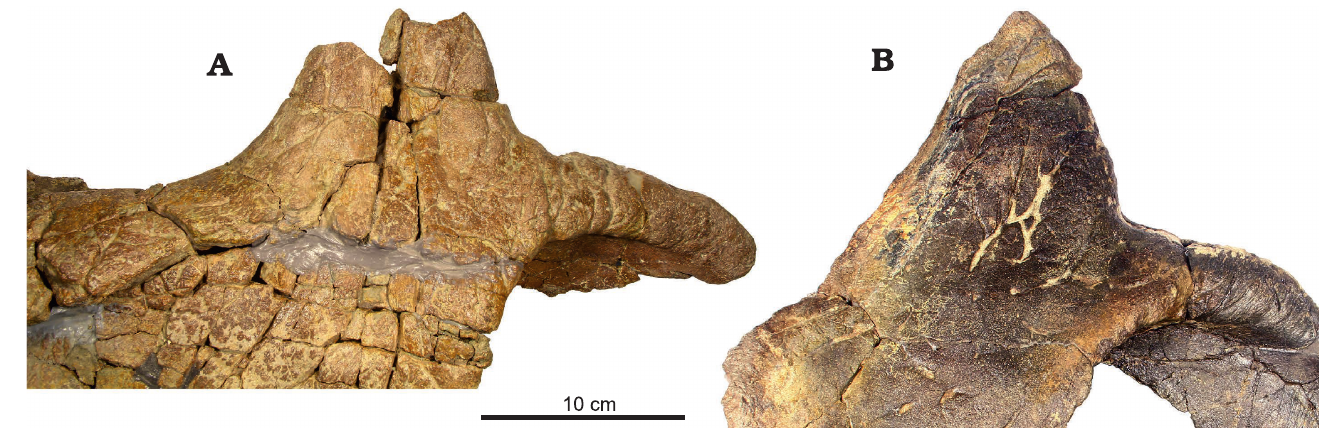
Fig. 2. Right lateral views of nasal horncores of Einiosaurus procurvicornis Sampson, 1995, MOR 456 8-8-87-1 ( A ) and eucentrosauran ( Einiosaurus procurvicornis or Achelousaurus horneri Sampson, 1995), MOR 591 ( B , mirrored), from the Campanian Two Medicine Formation, Montana,